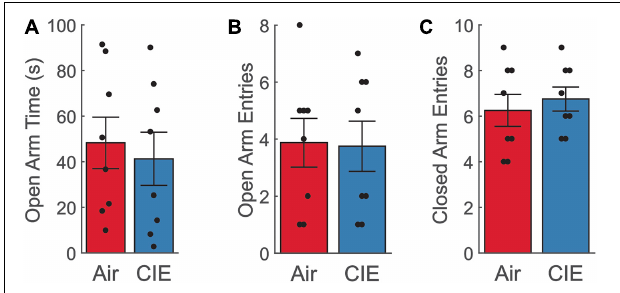
FIGURE 1 | Female CIE-treated rats do not show anxiety-like behavior on the EPM. (A) Air ( n = 8) and CIE-treated ( n = 8) rats spend similar amount of time in the open arms, (B) make similar number of open arm entries, and (C) closed arm entries. All data is expressed as the mean ±